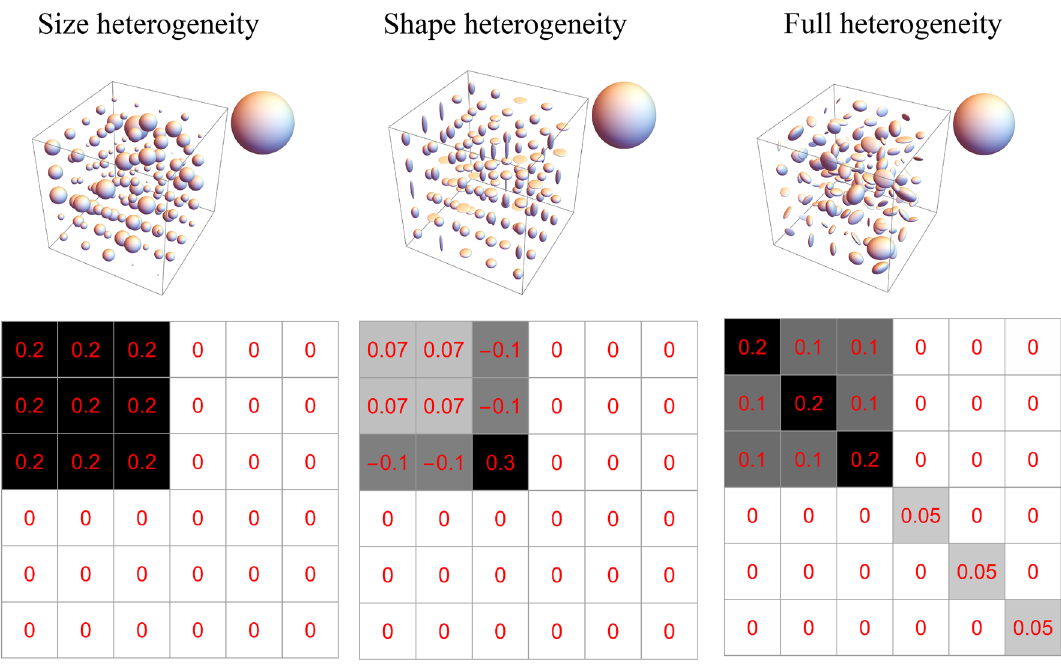
Figure 2. Macroscopically isotropic and microscopically heterogeneous DTDs generated from CNTVD describing gray matter. The DTD along with the mean diffusion tensor ellipsoid (inset) is shown in the top row 6 covariance matrix with non-zero elements highlighted is shown in the bottom while the structure of the 6 × row. (Left column) Emulsion type DTD with size heterogeneity, (Middle column) Shape heterogeneous DTD with a mixture of prolate, oblate and spherical diffusion tensors, (Right column) Fully heterogeneous DTD with randomly oriented tensors of varying shapes and sizes. The above graphics was generated using the Mathematica software 67